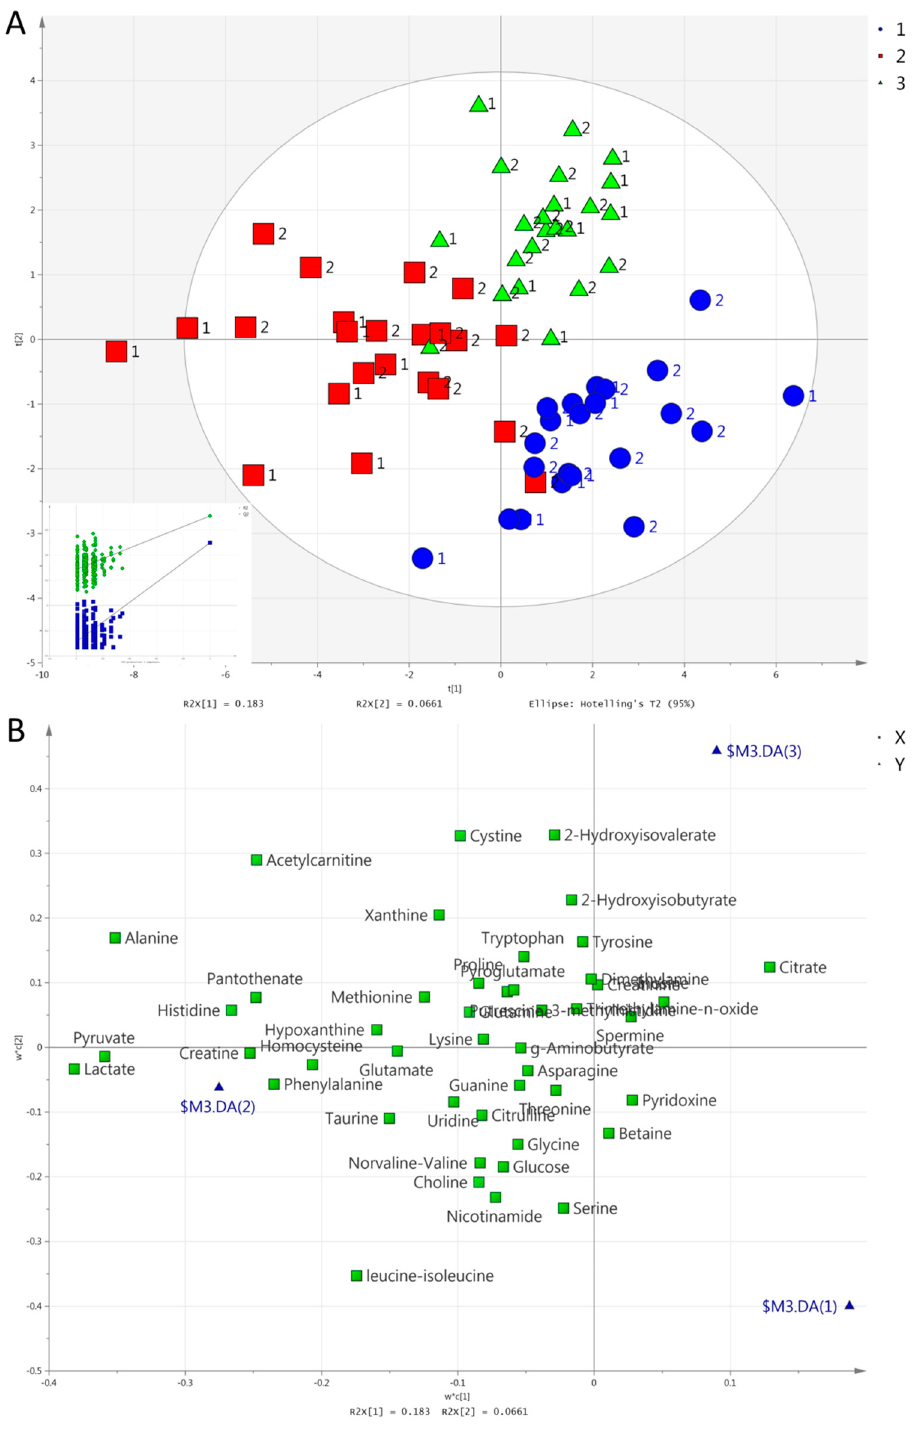
Figure 5. ( A ). Score plot concerning serum samples for the PLS-DA model for HIIE: 0 h (blue circles), 1 h (red squares), 2 h (green triangles). Inserts (subfigure) are permutation plots. The number 1 is used for the MetS group and 2 for the Healthy group. ( B ). Loading plot for the respective PLS-DA model. Blue triangles represent 0 h (1), 1 h (2), and 2 h (3).